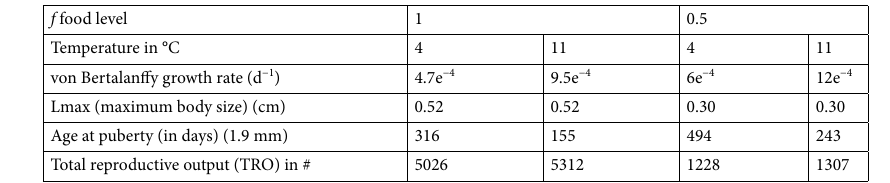
Table 3. Predictions of several fundamental functional traits of Xylonora atlantica using the abj-DEB model under different environmental scenarios of food level ( f ) and temperature (T, °C) with lifespans predicted by the abj-DEB model (~ 821 days at 4 °C and ~ 404 days at 11 °C). # Represents number of oocytes, f food level, d days.